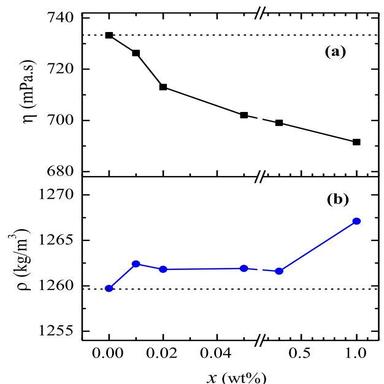
Plots of g and q with x (wt%) amounts of ZnO for the GLY/x (wt%) ZnO nanofluids, at 25 C.